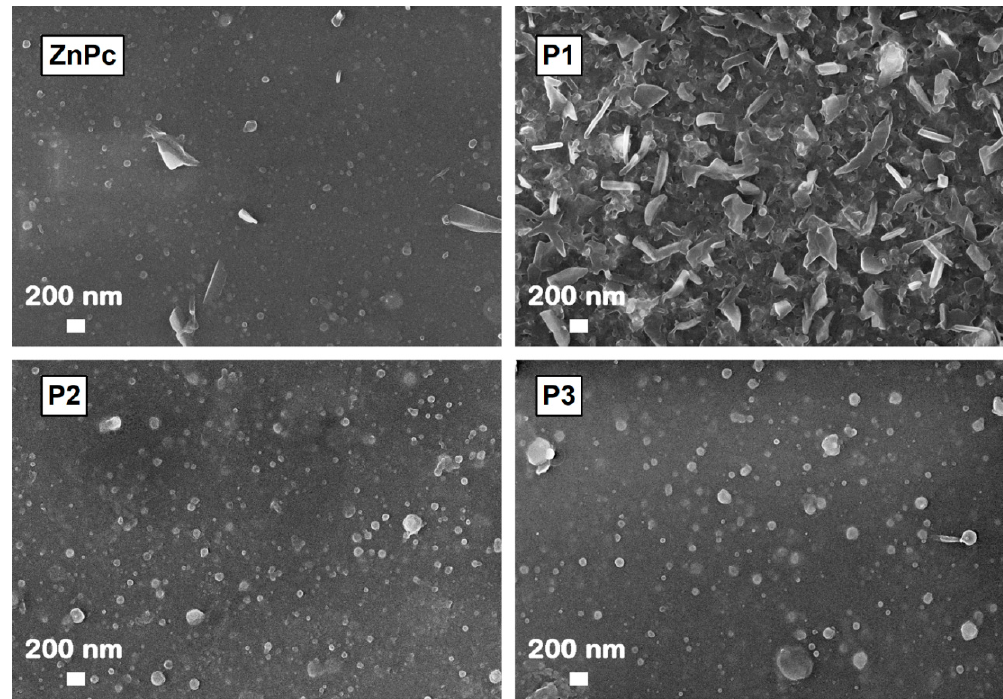
Figure 4. FESEM images of the MAPLE-deposited organic layers on silicon.